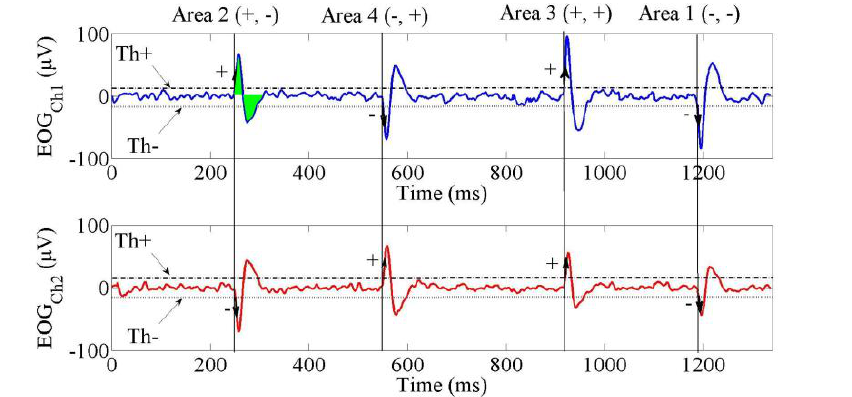
Figure 3. EOG signals for Areas 1, 2, 3 and 4.